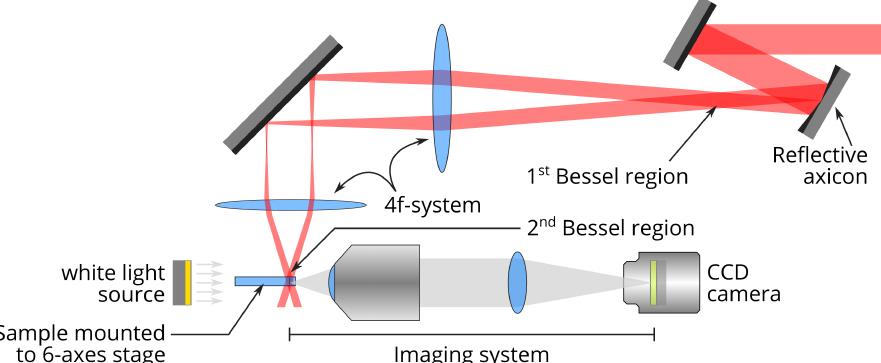
Figure 1. Experimental setup. Ultrafast laser beam is shaped by a reflective axicon (Cailabs). It is then demagnified by a telescopic arrangement in a 2f-2f configuration. Laser-written structures are observed using an incoherent white light source.